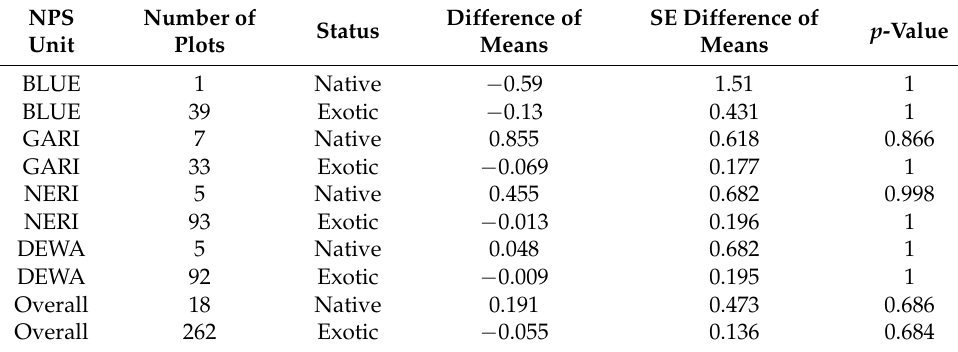
Table A6. Tukey method comparison for differences of means (disturbed–undisturbed) for change in plant richness (number of species per m 2 ) between disturbed and undisturbed plots for each NPS unit and for all the units combined following the disturbance